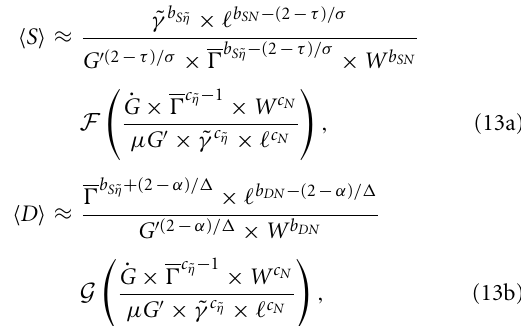
different symbols correspond to different values of k , given in the legend betweengraphs (A,B) .Inthemainpanelsofbothgraphs,theverticaldashlines indicates the transition value c / k between crackling and continuum-like dynamics as determined in Nukala et al. [40] for N = 1024 and ˜ η =